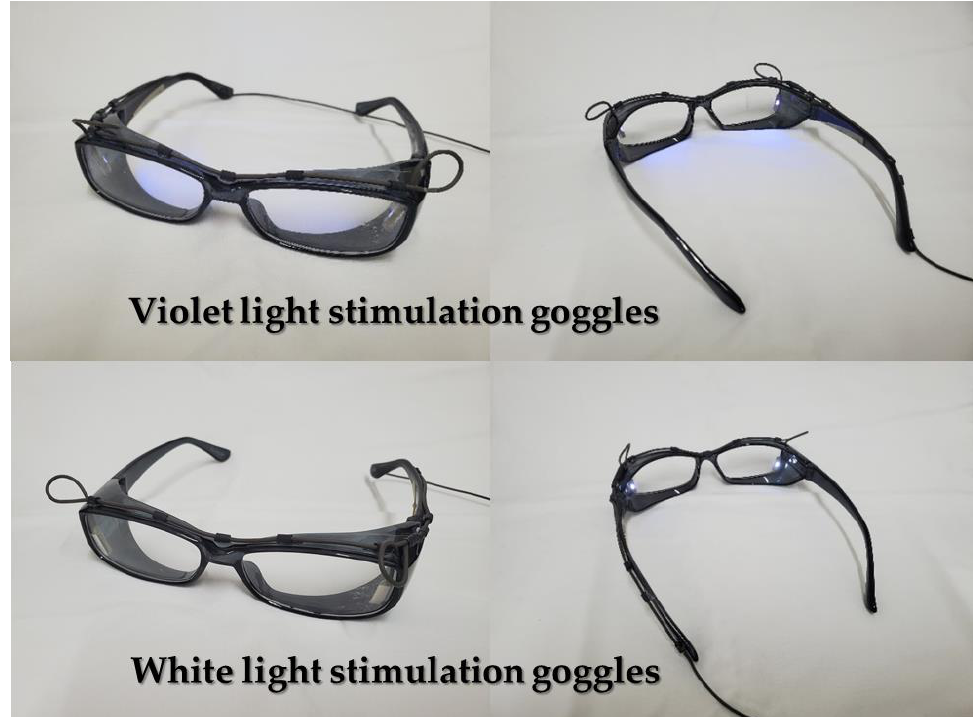
Figure 3. Goggles for violet light (VL) stimulation and goggles for white light (WL) stimulation used in this experiment.